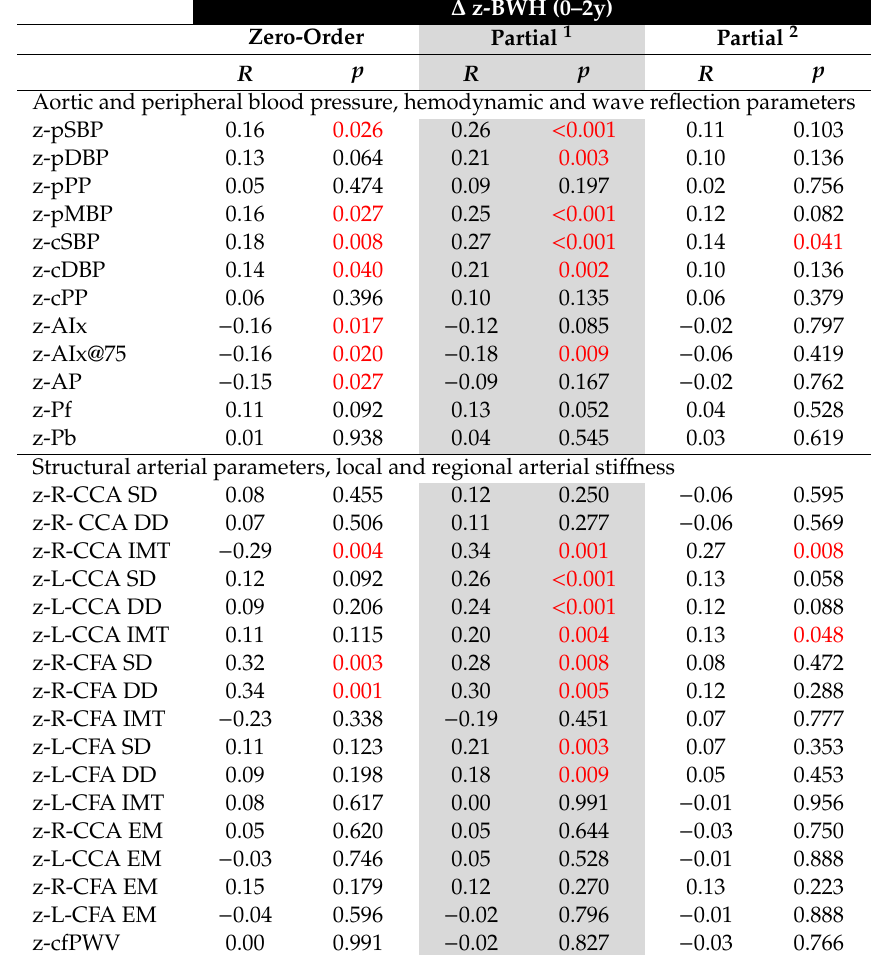
Table 5. Associations between CV z-scores and z-BWHvariations between 0–2y (childrencohort, n = 632).